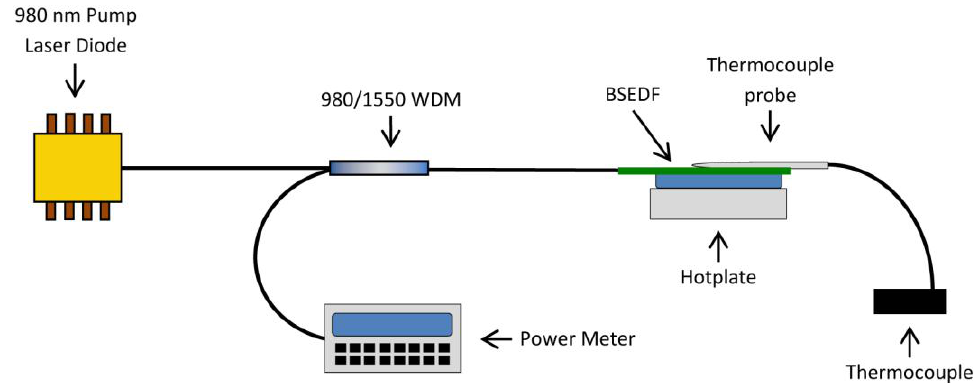
Figure 7. The setup for the sensitivity measurement of the BSEDF towards the